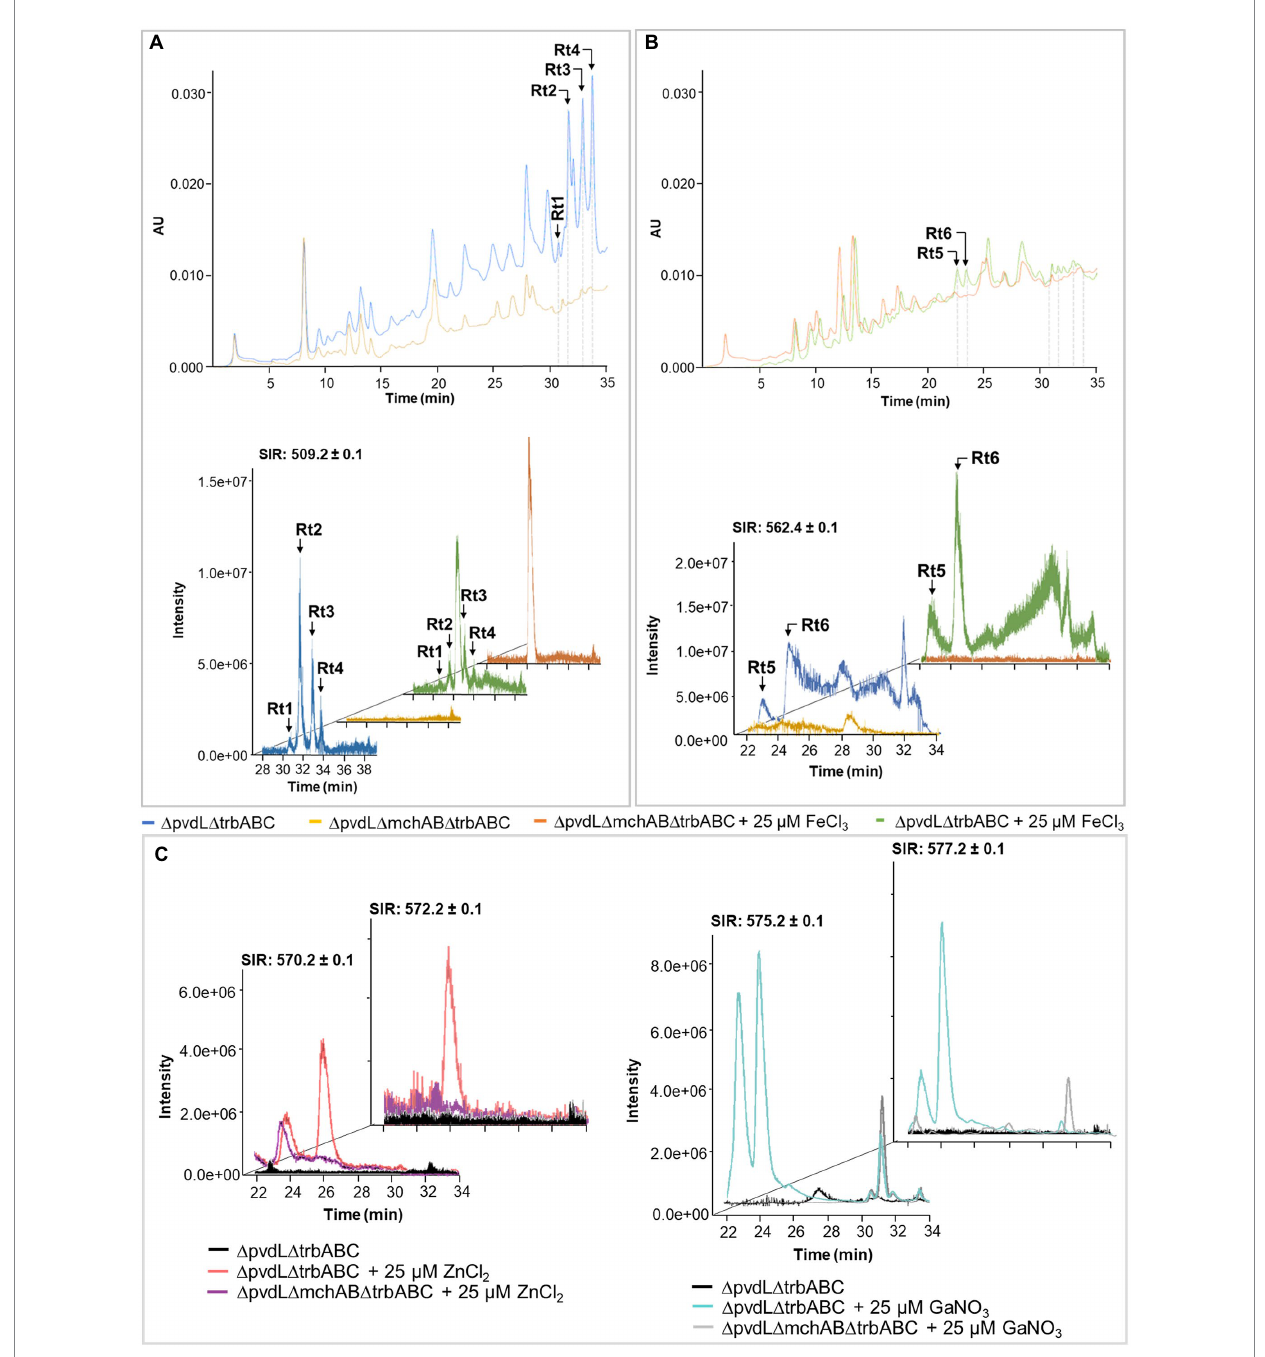
FIGURE 10 Evaluation of mupirochelin complexation with few metal ions by LC–MS analysis. (A) Apo mupirochelin (509.13 m/z ) is characterized by a four-peaks signal at Rt1 = 30.673 min, Rt2 = 31.576 min, Rt3 = 32.836 min and Rt4 = 33.673 min. Addition of 25 μ M FeCl 3 is responsible for the loss of apo mupirochelin signal at 254 nm and its attenuation in MS detection. (B) Mupirochelin forms a complex with Fe 3+ ions. Addition of FeCl 3 to the sample is responsible for the appearance of two peaks at Rt5 = 22.567 min and Rt6 = 23.380 min. In mass detection, these two peaks are linked to the presence of 562.44 m/z analytes corresponding to the ferri-mupirochelin complex [M + Fe – 2H] + . (C) Mupirochelin chelates Zn 2+ and Ga 3+ ions. Addition of ZnCl 2 to the sample (left) is responsible for the emergence of a peak mainly consisting of analytes 570.24 and 572.24 m/z suggested to be the zinc-mupirochelin